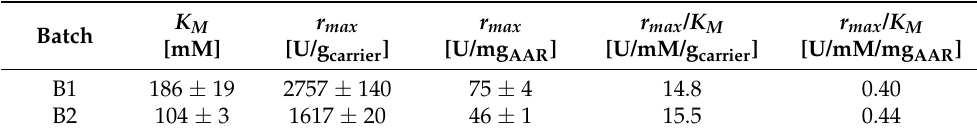
Figure 5. ( a ) Reaction rates for D -Met (light green) in comparison with L -Met (dark green) from batch B1 (solid line) and B2 (dashed line) in pure water at 20 ◦ C. ( b ) Relative activity of other L -amino acids normalized to the activity of L -Met (red dotted line). Table 5. Kinetic parameters of immobilized AAR for D -Met of B1 and B2 at 20 ◦ C in pure water, Equation